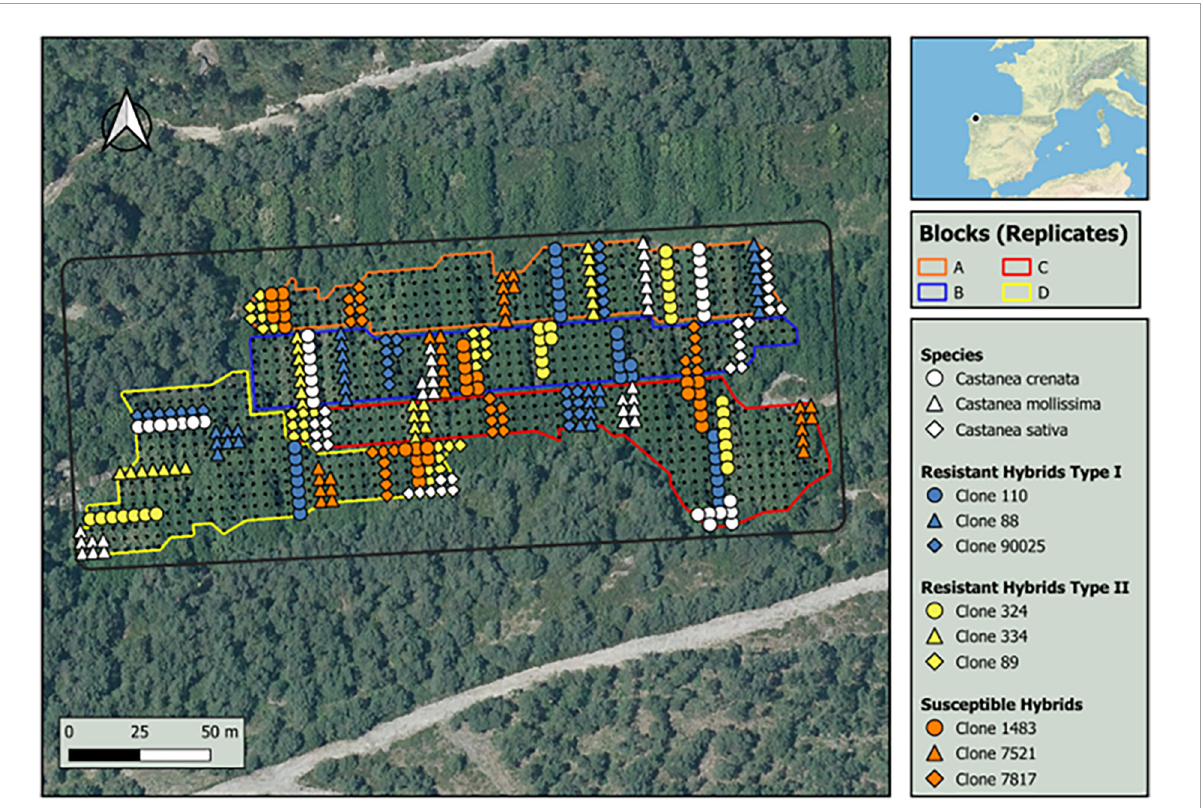
FIGURE1 Location of the field trial in Galicia (NW of Spain), and of the selected genotypes within the four